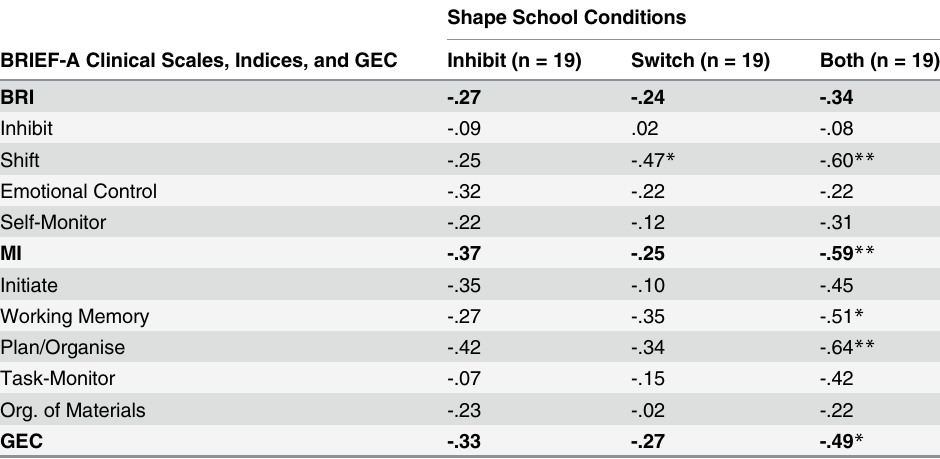
Table 3. Correlations Between the Shape School and the BRIEF-A (T